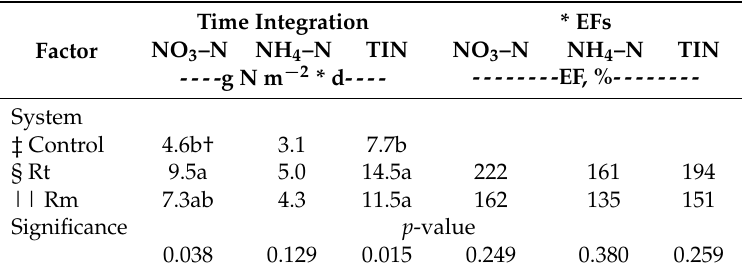
Table 2. Treatment means and significance of soil N pools post residue management prior to row